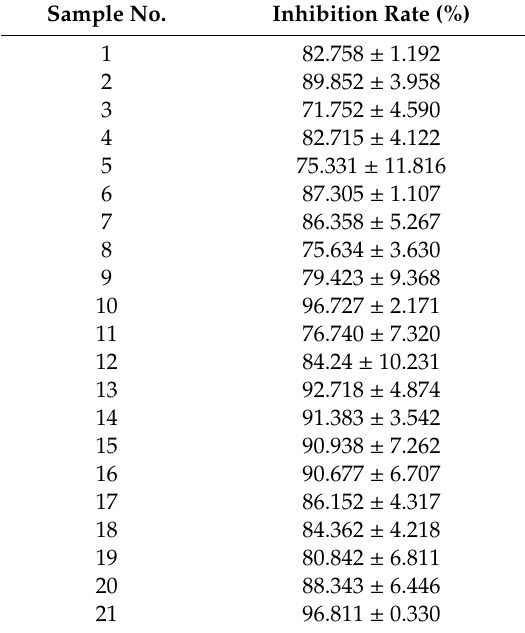
Ordinary one ‐ way ANOVA, **** p < 0.00001 indicates a significant difference versus the control group. Table 5. The inhibition rate of toad venom extracts (